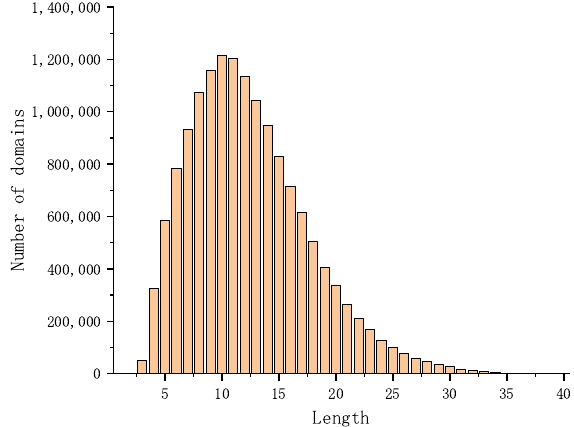
Figure 3. Distribution of lengths of all the registered .net